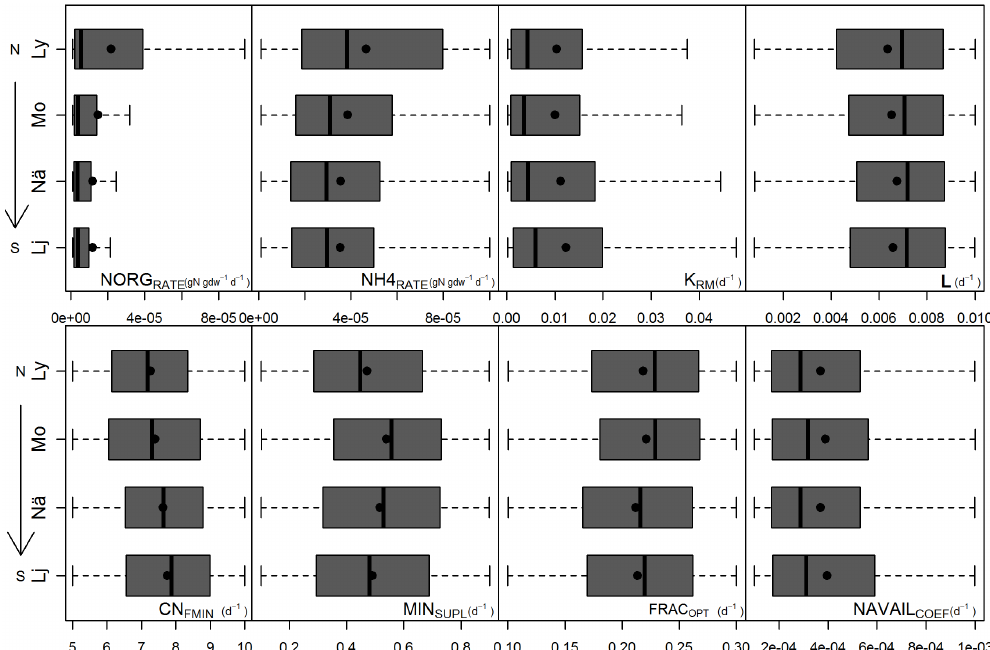
Figure 8. Posterior parameter distributions of ECM fungal-specific parameters (from top left to bottom right): organic N uptake rate ) , respiration coefficient ( K RM ) , ECM fungal litter rate coefficient (the rate at which mycelia (NORG RATE ) , ammonium uptake rate (NH 4 RATE and mantle die and add to the soil litter pool, L) , minimum ECM fungal C / N ratio (CN FMIN ) , ECM minimum N supply to plant (MIN SUPL ) , optimum ratio between ECM and root C content (FRAC OPT ) , and N sensitivity coefficient (NAVAIL COEF ) . Distributions are presented as box plots over the prior range of variation (corresponding to the range on the x axis). Box plots depict the median (bold line), the mean (black point), the 25th and 75th percentiles (bars), and the 10th and 90th percentiles